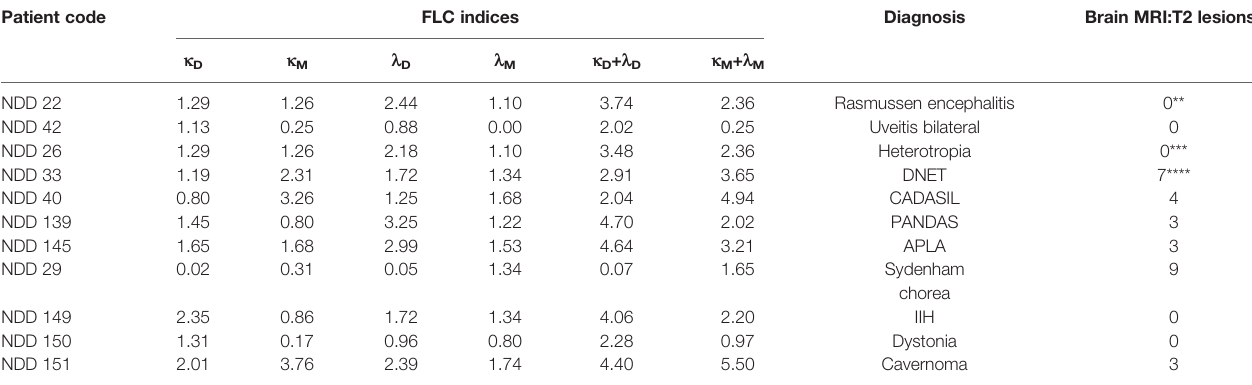
TABLE 2 | Pediatric patients with non-demyelinating diseases: diagnosis, saliva FLC indices, and radiological fi ndings. Patient